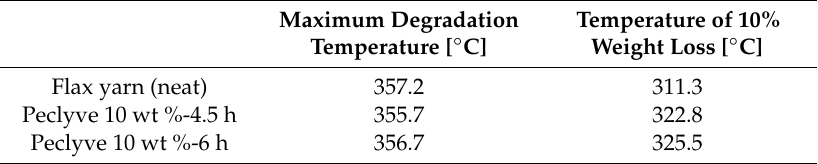
Table 4. Results of the thermogravimetric analysis for the di ff erent types of flax